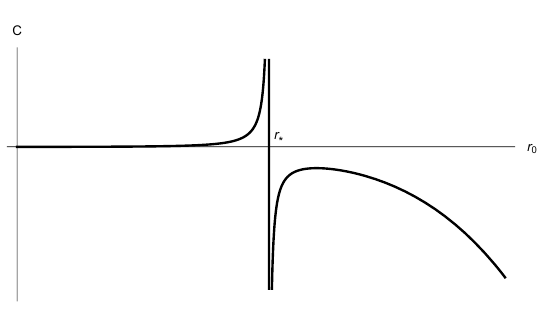
Figure 4 . Specific heat C vs r 0